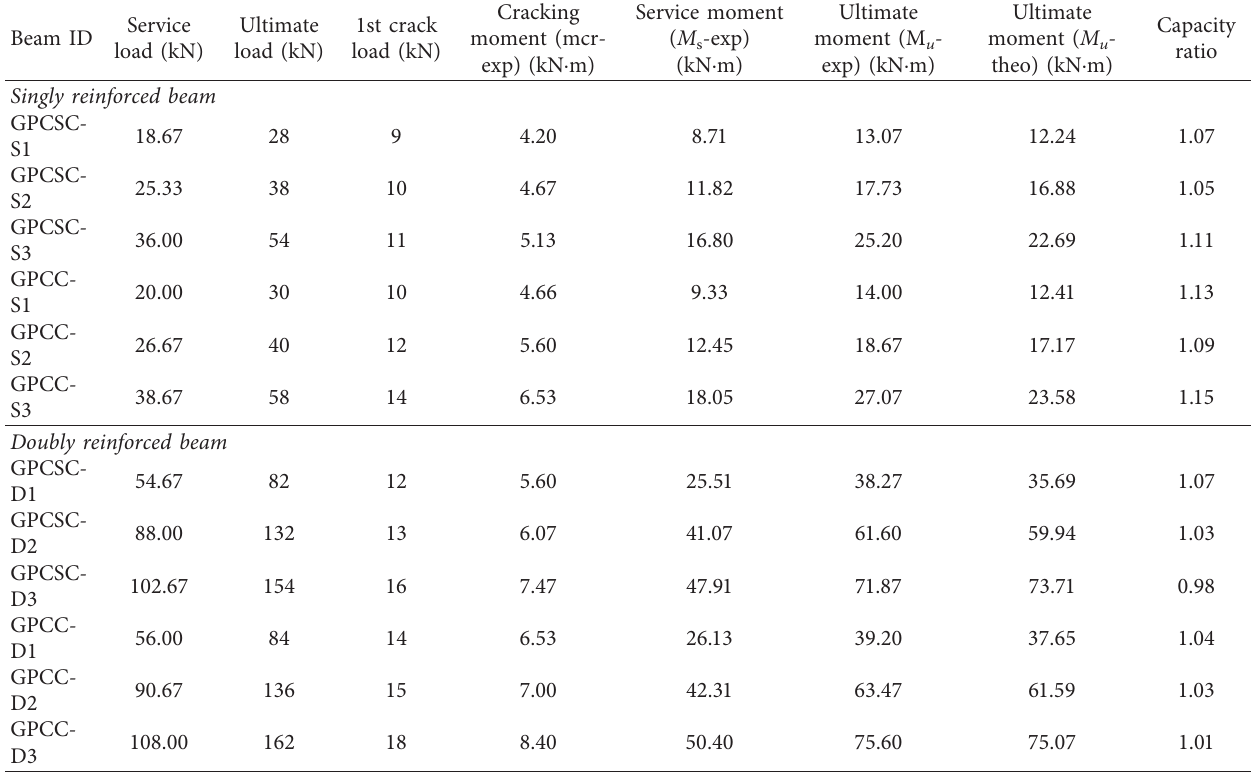
Table 6: Comparison of test results at service stage and ultimate stage.